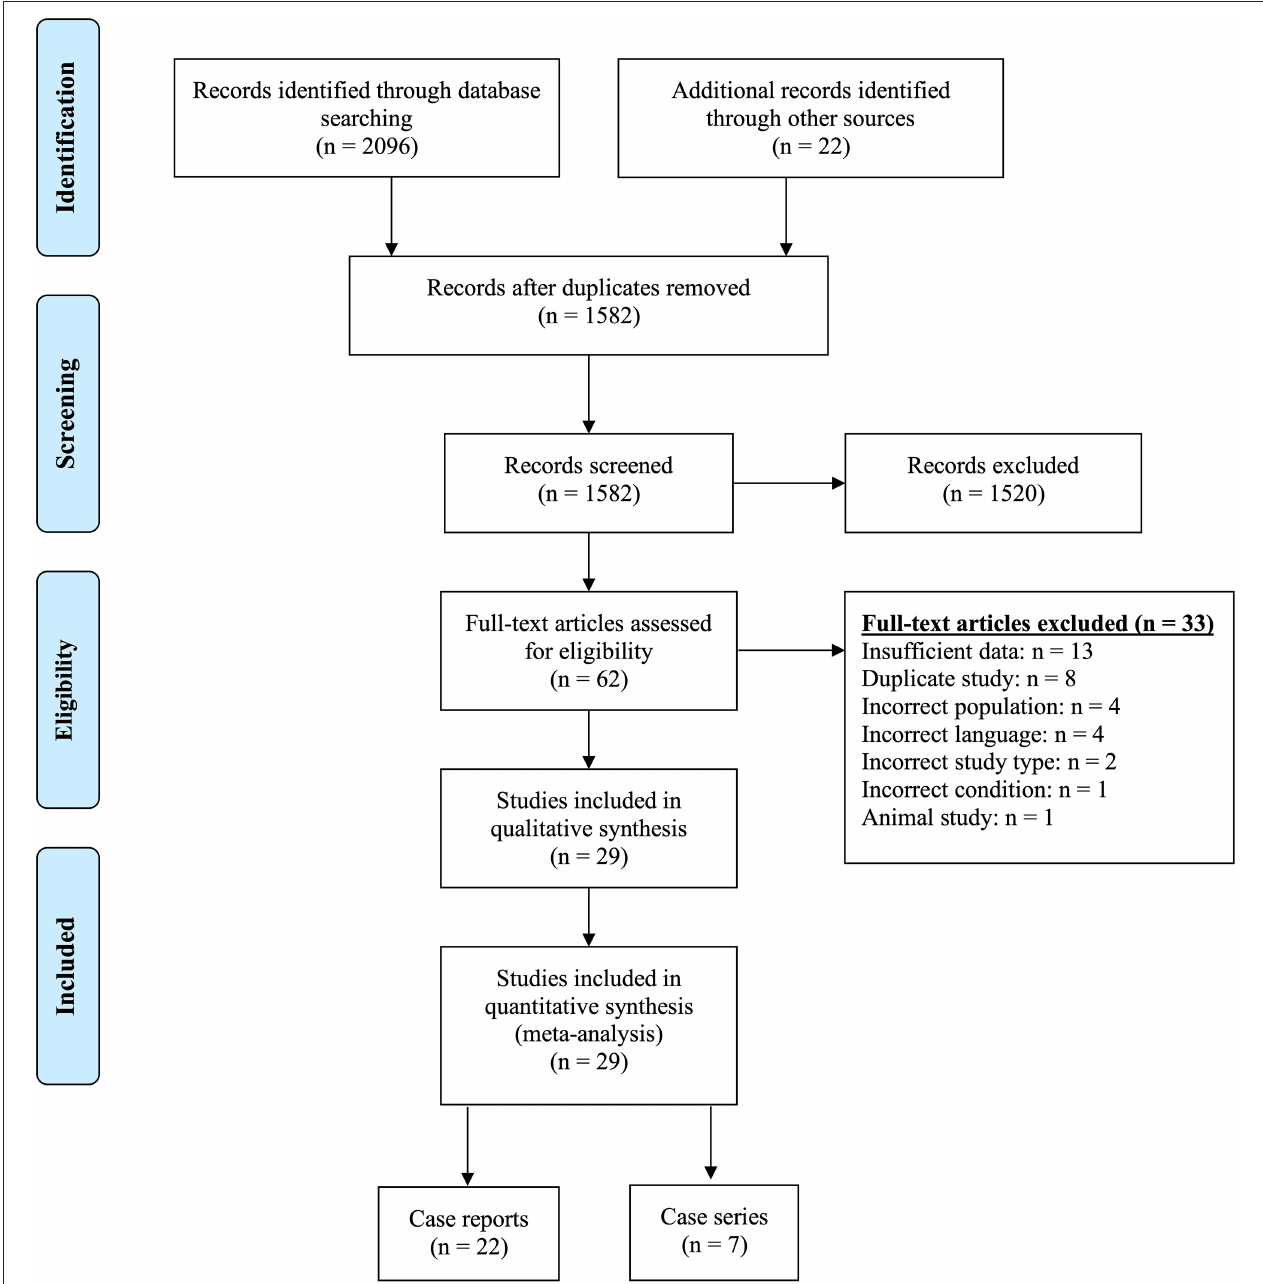
FIGURE 1 | PRISMA